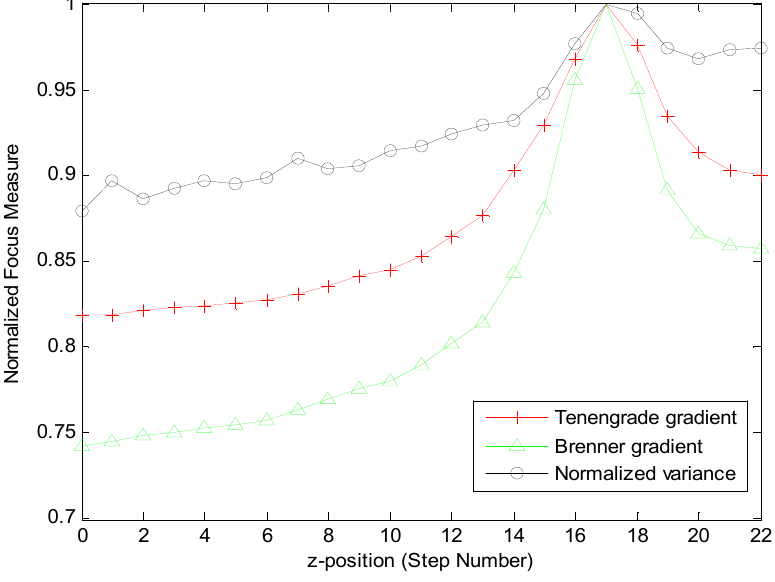
Figure 4. Focus curves after normalization.